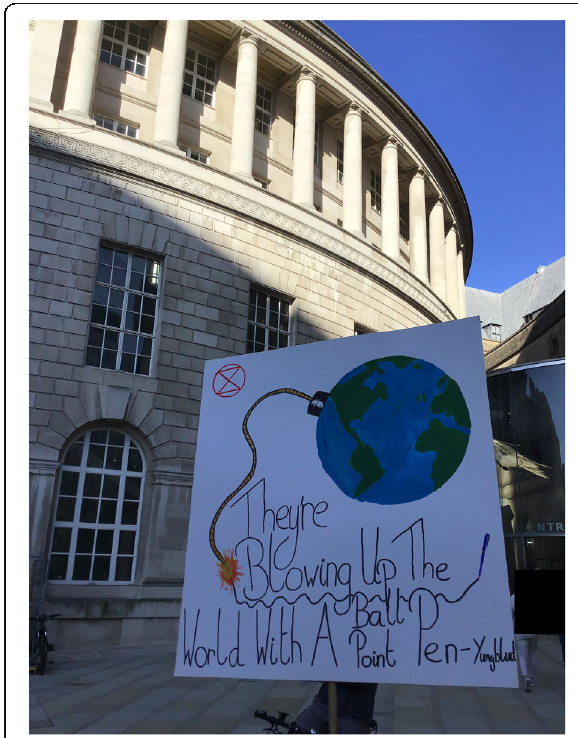
Fig. 3. Protest sign: 'They're Blowing Up The World With A Ball Point Pen -